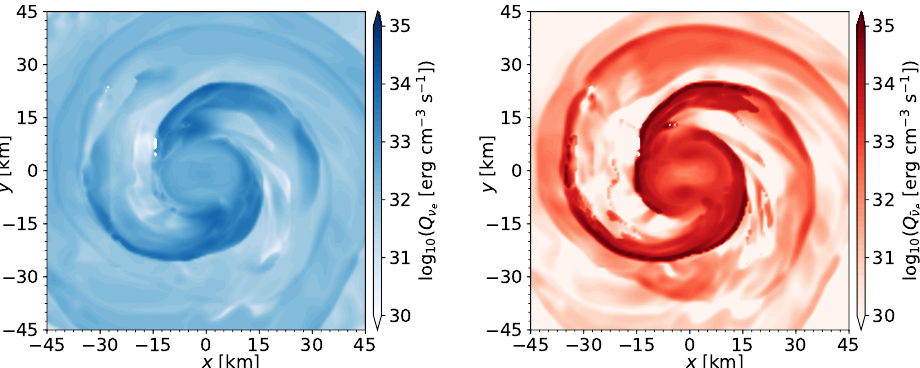
Figure 12. Effective emissivities 10 ms after the merger in the x - y plane of electron neutrinos ( left panels) and electron antineutrinos ( right panels) for the BHB Λ φ - ν run. Differently than for the cold ID case, we notice that the emissivities at the core are greater as a consequence of the isentropic thermal profile, which produces temperatures of tens of MeV within the NSs. The more potent emissions are found in the outer core and along the spiral arms, mostly in the inner disk